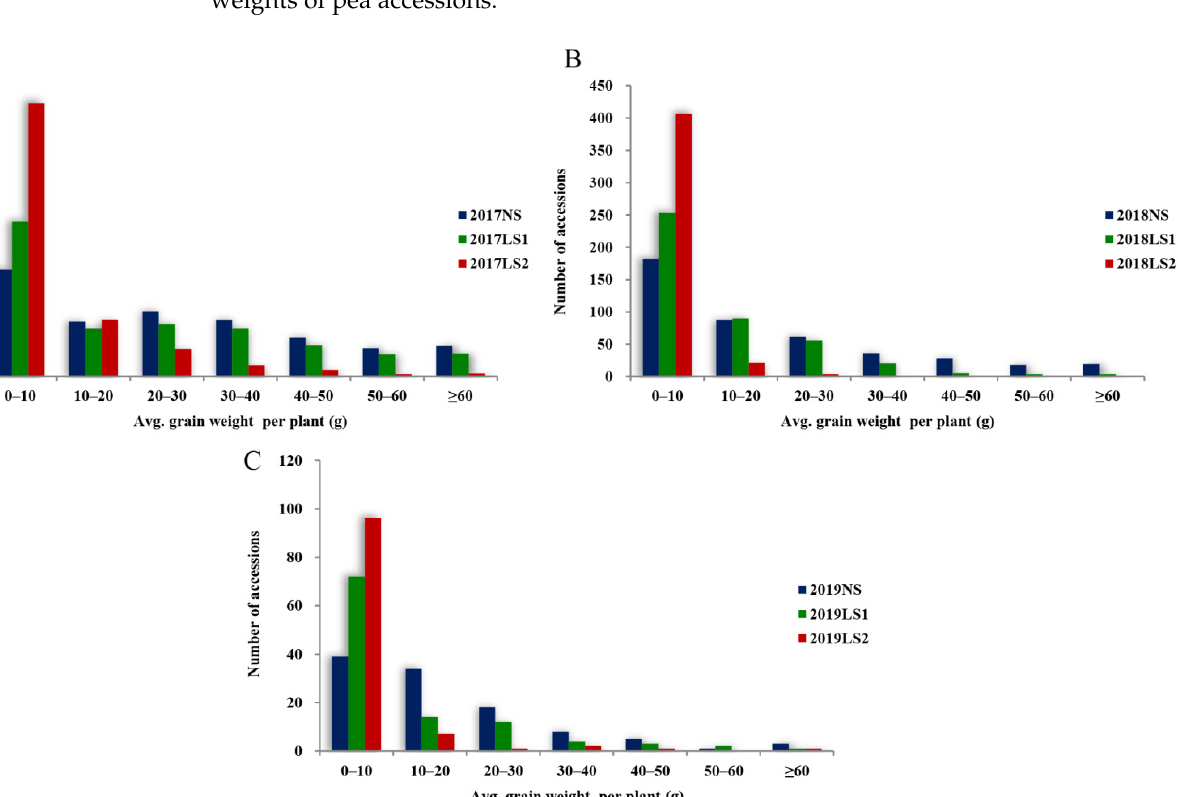
Figure 4. Distribution of average grain weight per plant of each pea accession after the three heat-tolerance screenings. ( A ) HST1 in 2017. ( B ) HST2 in 2018. ( C ) HST3 in 2019. tolerance screenings. ( A ) HST1 in 2017. ( B ) HST2 in 2018. ( C ) HST3 in